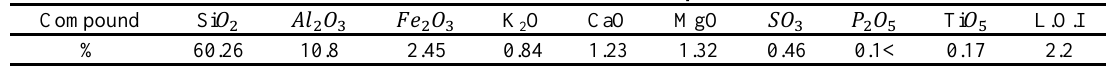
Table 1 Bentonite chemical